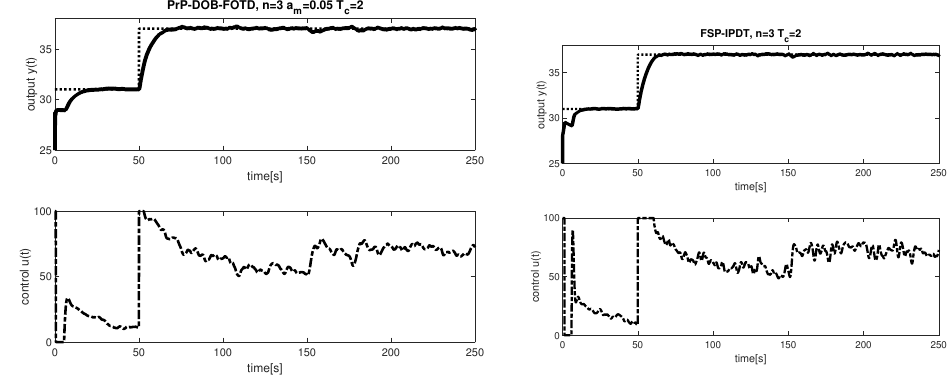
Figure 12. Experiment cycle: plant output response at the initial reference temperature w 0 = 31 ◦ C with the fan input u fan 1 = 5, transient to w 1 = 37 ◦ C at t = 50 s and a disturbance step produced by an increased fan input u fan 2 = 15 at t = 150 s; experiment with PrP-DOB control ( left ) and with the FSP inspired solution ( right ); n = 3; T c =